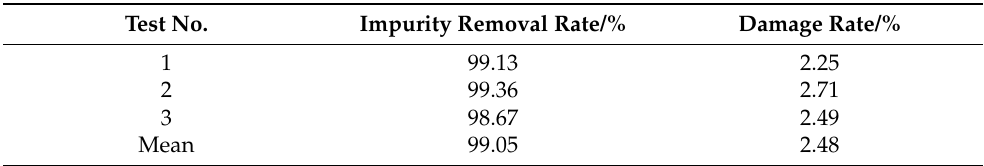
Figure 14. The gradient cleaning process of potato. ( a ) Dry-cleaning; ( b ) Pre-cleaning; ( c ) Rough cleaning; ( d ) Fine cleaning of ultrasonic; ( e ) Fine cleaning of bubble; ( f ) Cleaning effect. Table 1. Results of cleaning test. Test